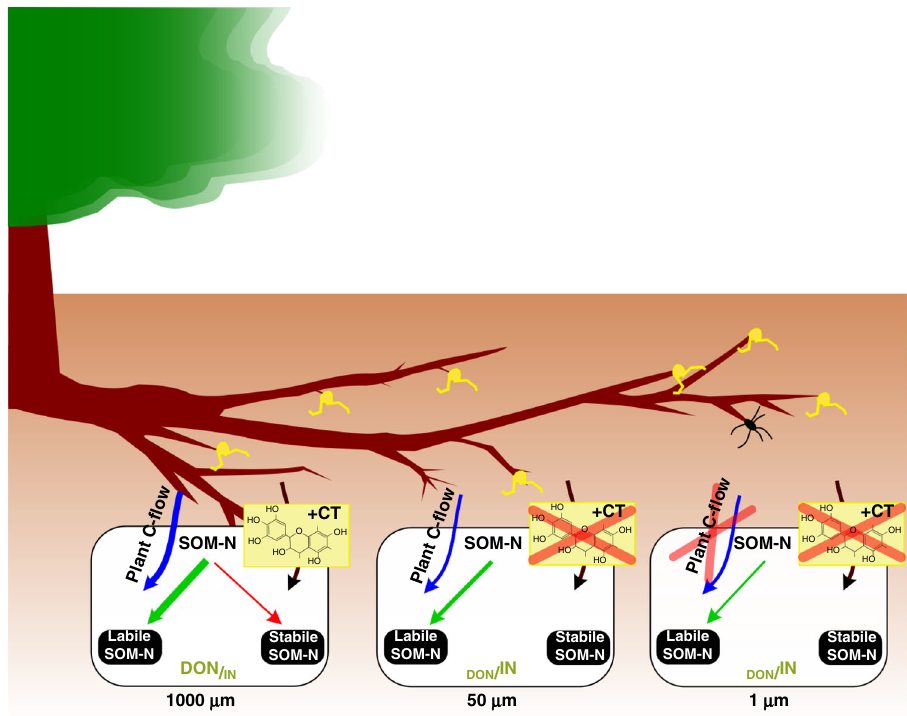
Fig. 4 Framework of SOM-N transformations: organic N economy under natural conditions (1000 µ m), inorganic N economy for exclusion of roots (50 µ m), as well as roots and fungal hyphae (1 µ m). Organic N economy (i.e. the domination of organic N) includes also build-up of stable SOM due to stabilization of organic N compounds with plant-derived tannins. Exclusion treatments (50 and 1 µ m) led to an inorganic N economy (i.e. increased concentration of inorganic N forms) with reduced SOM build-up. The arrow thickness is proportional to the magnitude of the net fl ux. CT condensed tannins (shown as a monomer), SOM soil organic matter, DON dissolved organic N, IN inorganic N. The sizes of DON and IN are proportional to their